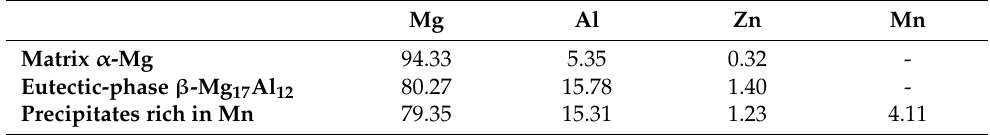
Figure 13. SEM image of microstructure in longitudinal section. Table 8. Results of EDS chemical microanalysis of individual phases [wt.%].